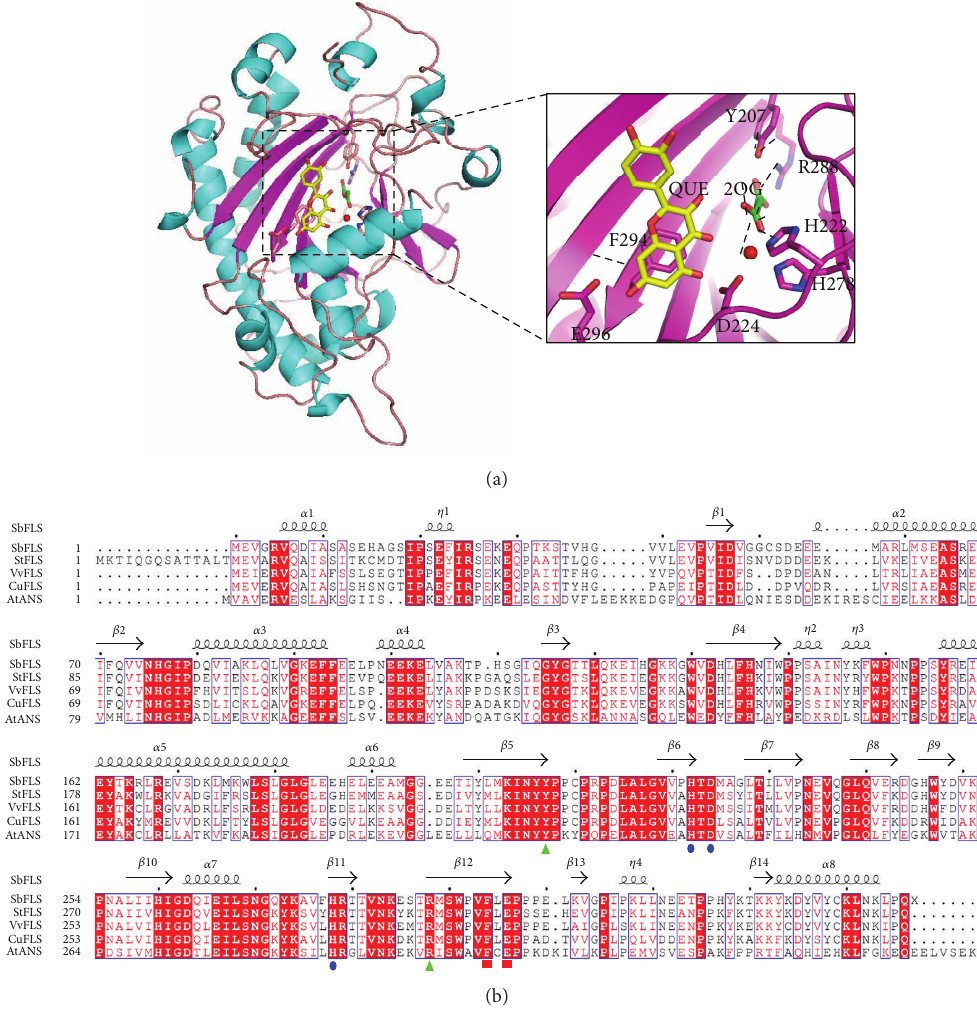
Figure 3: The structural model of SbFLS. (a) The overall and detailed views of the structure of SbFLS showing the 𝛽 jelly-roll fold and presumed catalytic site are modeled using SWISS-MODEL server (http://swissmodel.expasy.org/) [27]. Iron atom is represented by a red dot. Substrates quercetin (QUE) and 2-oxoglutarate (2OG) are indicated in yellow and green. The iron, QUE, and 2OG are positioned by the same structure identified in the AtANS complex (PDB code 1GP6). Possible hydrogen bonds are indicated by dashed lines. (b) Sequence alignment of AtANS and various FLSs from S. baicalensis (SbFLS), V. vinifera (VvFLS), C. unshiu (CuFLS), and A. thaliana (AtFLS). The secondary structure was drawn from the modeled structure of SbFLS. Residues coordinating with an iron atom are represented by blue ovals. Green triangles and red rectangles indicate residues that interact with 2OG and QUE, respectively. The figure was produced using the ESPript server (http://espript.ibcp.fr/ESPript/ESPript/)